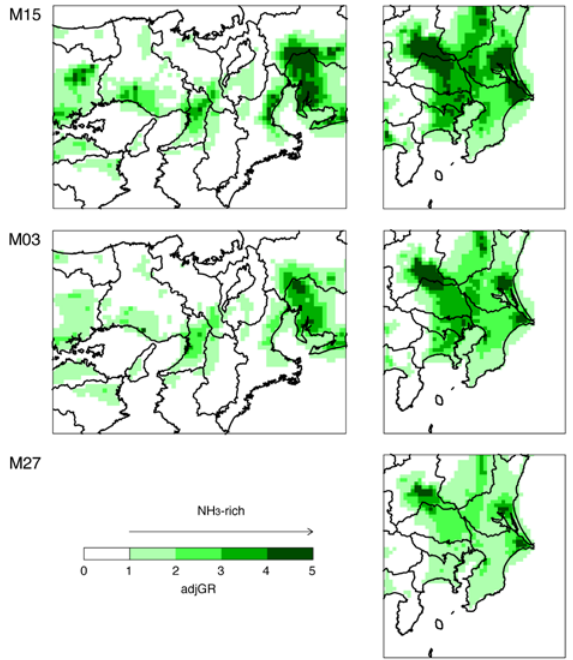
Figure 11. Spatial distributions of adjGR by M15, M03, and M27 over (left) domain 3 and (right) domain 4.